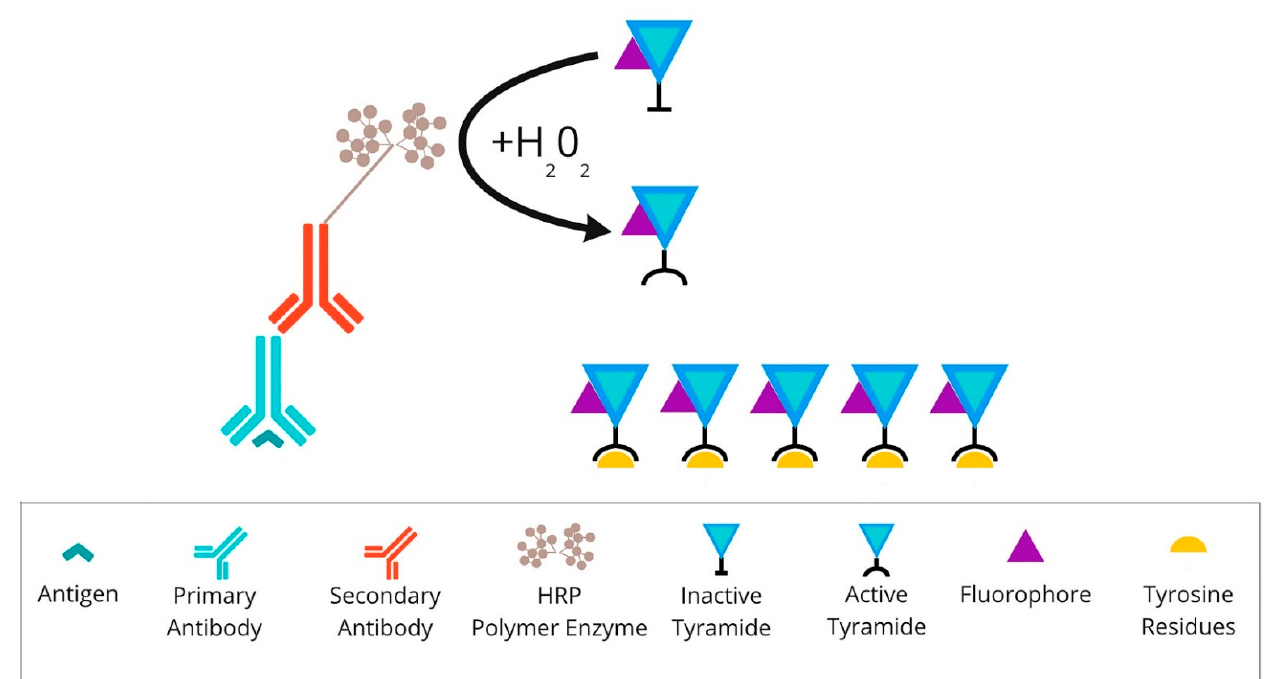
Figure 3. Overview of tyramide signal amplification technique: After primary antibody incubation, secondary antibody labelled with HRP polymer enzymes is conjugated. Detection is achieved using the fluorophore-labelled HRP substrate, tyramide. HRP converts tyramide into a highly reactive oxidised intermediate that binds covalently to tyrosine residues present on or near the protein of interest. Abbreviations: HRP—horseradish peroxidase. interest. Abbreviations: HRP—horseradish